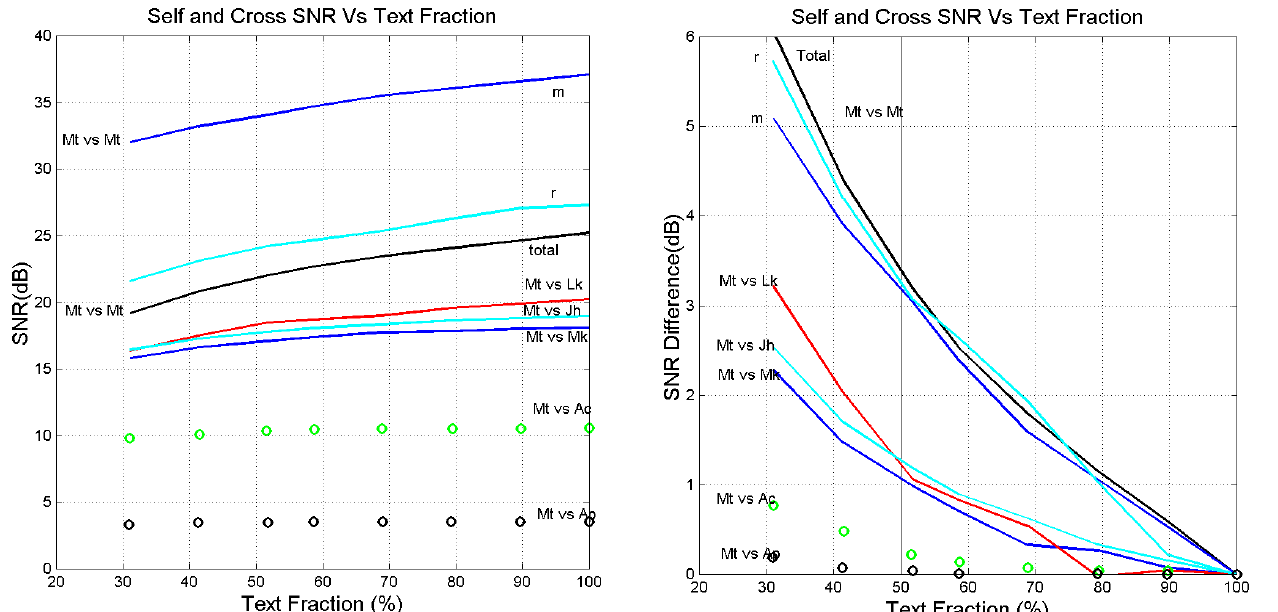
Figure 13. ( Left panel ): Average values of Γ dB (total), Γ m , dB ( m ) and Γ r , dB ( r ), versus fraction f ( % ) of text considered in Matthew self-channel and total Γ dB in the cross-channels indicated. ( Right panel ): Difference between the average signal-to-noise ratio obtained with full text (100%) and that obtained with reduced text in the same channels.